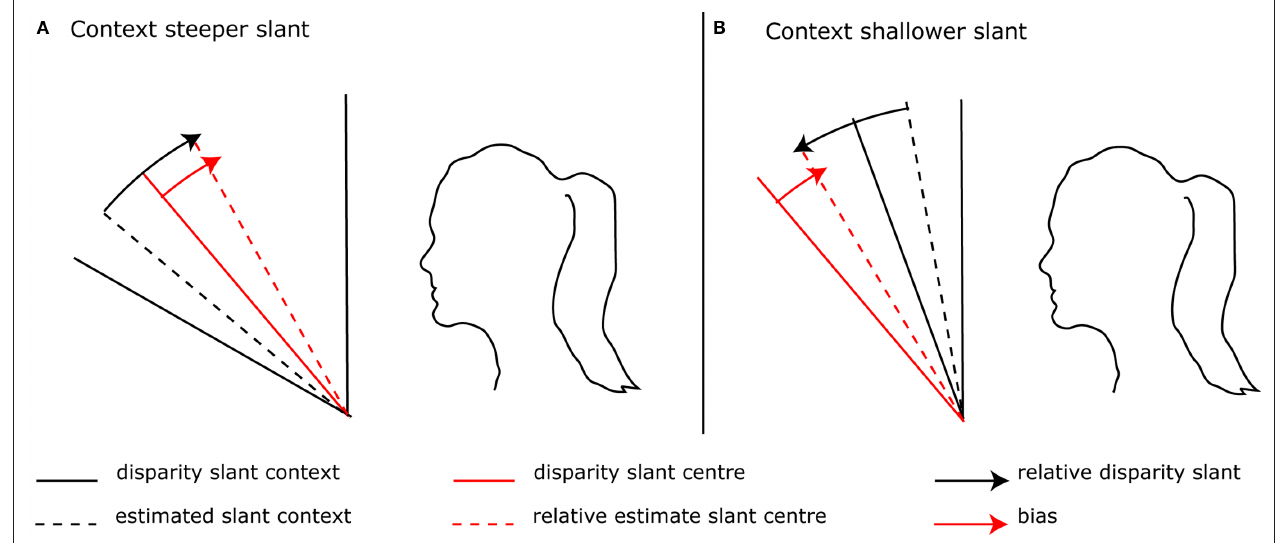
Figure 2 | gaging relative disparity to an underestimation of contextual slant. (A) When the context has a steeper slant than the central surface a contrast bias occurs. (B) But when the context has a shallower slant than the central surface, an assimilation instead of contrast bias